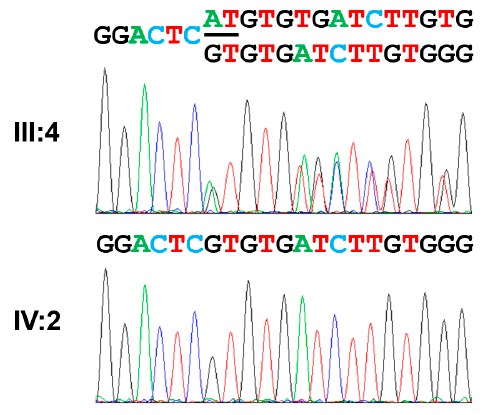
Figure 4. Sequencing chromatograms. Heterozygous deletion of AT (marked with a black bar under the sequence) in the normal but heterozygous individual, III:4, results in a mixed peak from the deletion. A sequencing chromatogram of the proband (IV:2) shows a homozygous AT nucleotides deletion. The deletion mutation is indicated as c.1467_1468delAT (NM_182758.4) and p.(Val491Aspfs*8).